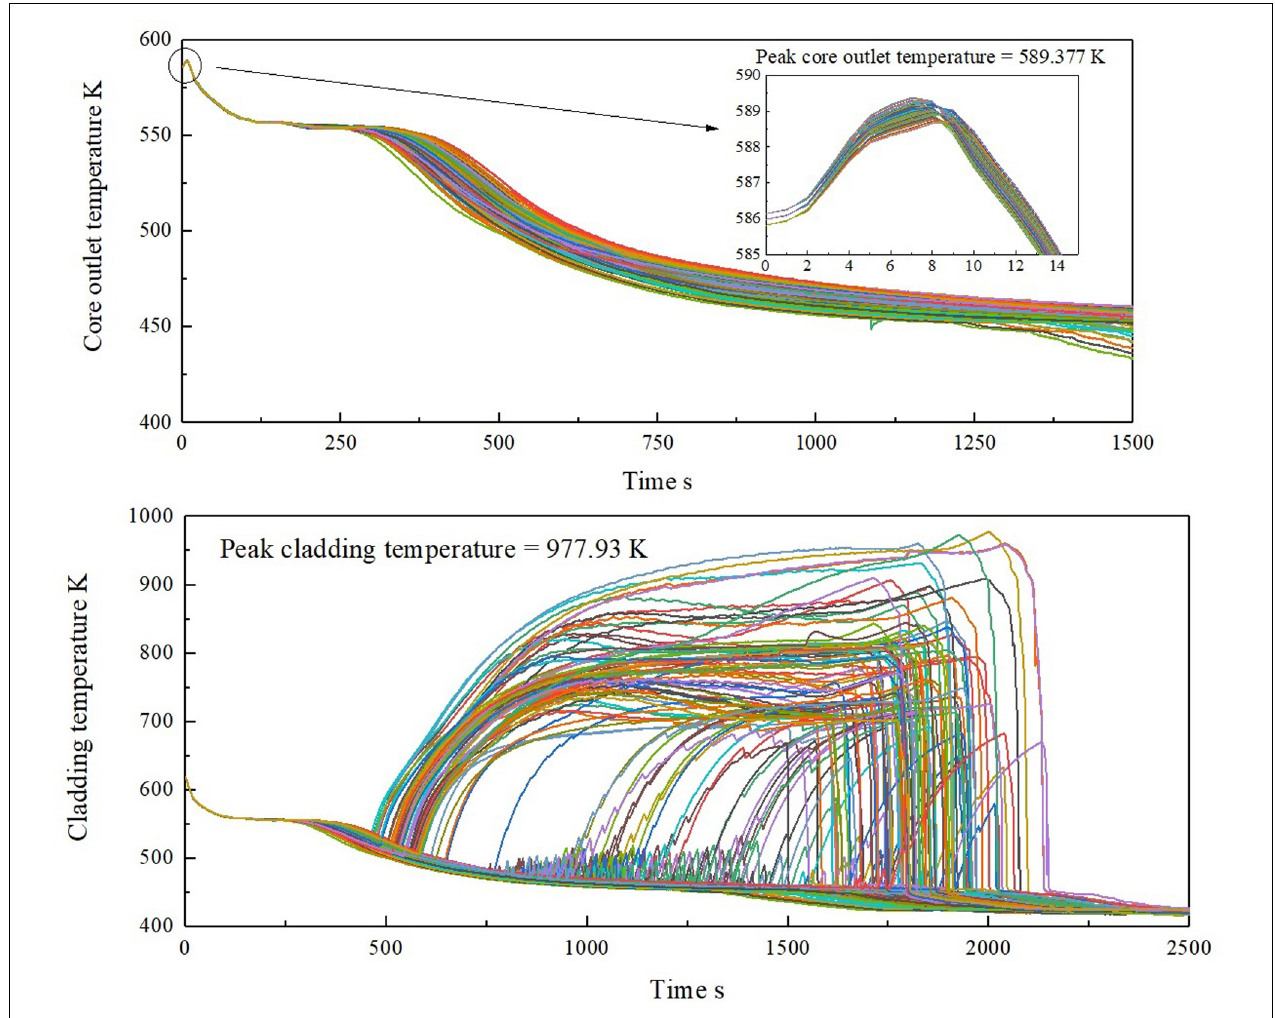
FIGURE 11 | Uncertainty results of figures of merit (FOMs) with improved best estimate plus uncertainty (BEPU) method. (A) Results of the peak core outlet temperature. (B) Results of the peak cladding temperature